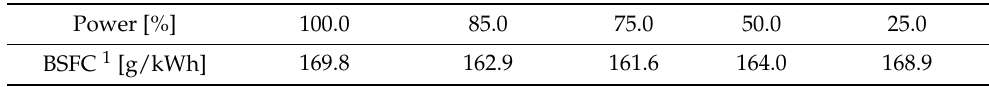
Table 6. BSFC data of the WinGD RT-flex 58T-E diesel engine (Data from [37]). Power [%] Power [%]